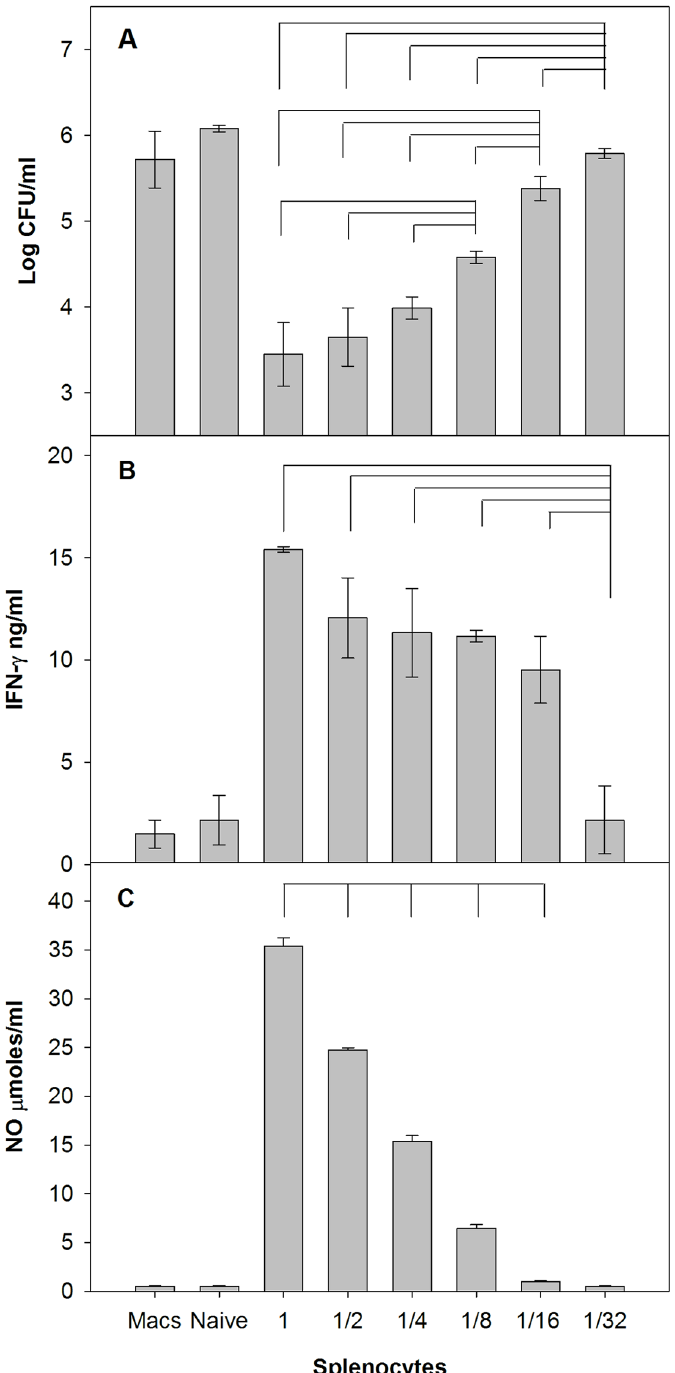
Fig 1. Rat splenocytes control intramacrophage Francisella growth that is accompanied by IFN- γ and NO production. BMM F from Fischer 344 rats were infected with LVS (Macs), and co-cultured with naïve splenocytes or with immune splenocytes derived from LVS-vaccinated rats. Decreasing numbers of splenocytes were added to a constant number of confluent LVS-infected macrophages, where 1 = 5 x 10 6 , 1/2 = 2.5 x 10 6 , 1/4 = 1.25 x 10 6 , 1/ 8 = 0.625 x 10 6 , 1/16 = 0.312 x 10 6 , 1/32 = 0.156 x 10 6 splenocytes. After three days of co-culture, BMM F were lysed to evaluate the recovery of intracellular bacteria (Panel A). Values shown are the mean numbers of CFU/ml ± SD of viable bacteria from triplicate wells. Supernatants were collected for analyses of IFN- γ by ELISA (Panel B) and NO by Griess reaction (Panel C), and concentrations of each were calculated using standard curves as references. Values